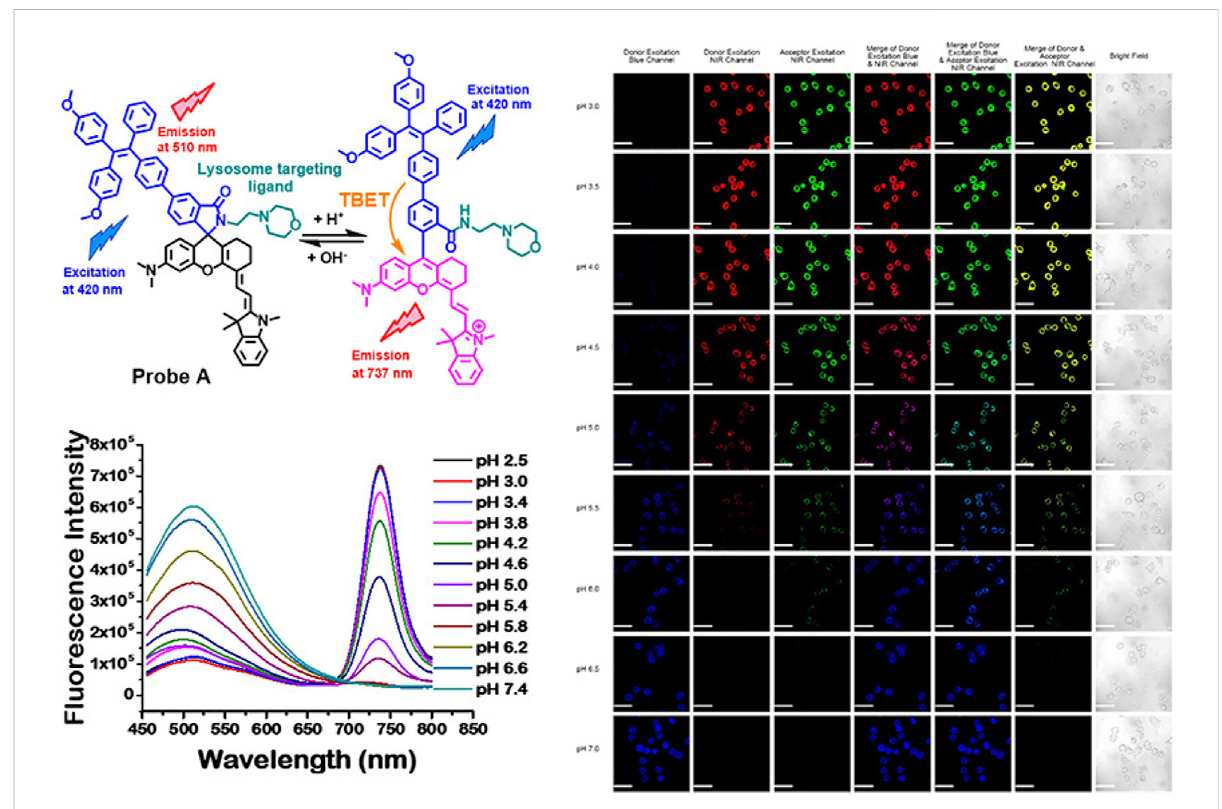
FIGURE 5 Chemical structure responses of ratiometric near-infrared fl uorescent probes to pH changes; fl uorescence spectra of 5 µM probe A in 10 mM citrate buffers with different pH values, containing 30% ethanol under an excitation of 420 nm; fl uorescence images of HeLa cells incubated with 15 µM fl uorescent probe A (Wang et al.,